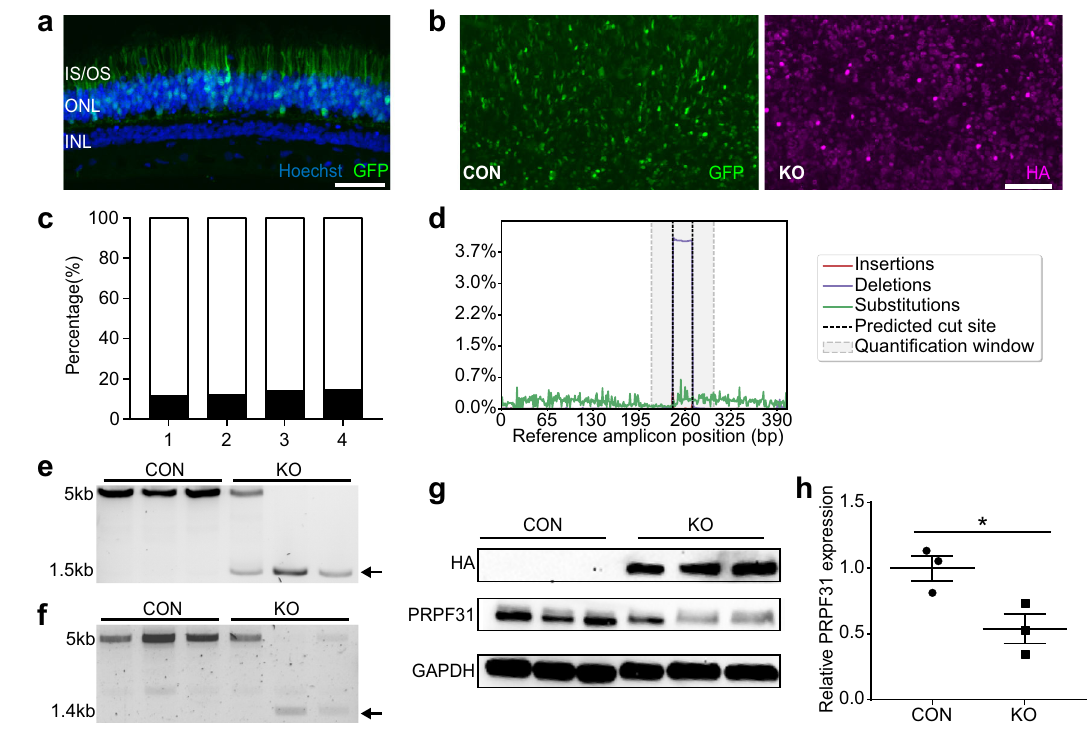
Fig. 9 | KO of PRPF31 in NHP and human retinal explants demonstrates the feasibility of establishing a non-human primate PRPF31 RP model. a GFP expressionintheouterretinaofmacaqueretinalexplant9dayspostAAVinfection. Scalebar,50 μ m. b GFPexpression(left)andimmunolabelingofanti-HAtag(right) con fi rmed the successful expression of HA-tagged Cas9 in human retinal explant fl atmounts. c Deep sequencing of DNA from the 7m8-SaCas9-gRNAa/b infected human explants revealed editing ef fi ciency of 12.76±1.43% at the gRNAa/b target regionof PRPF31 ( n =4). d Mutationpatternofmodi fi ed PRPF31 from 7m8-SaCas9- gRNAa/b infected human retina explants. The main editing event identi fi ed was a